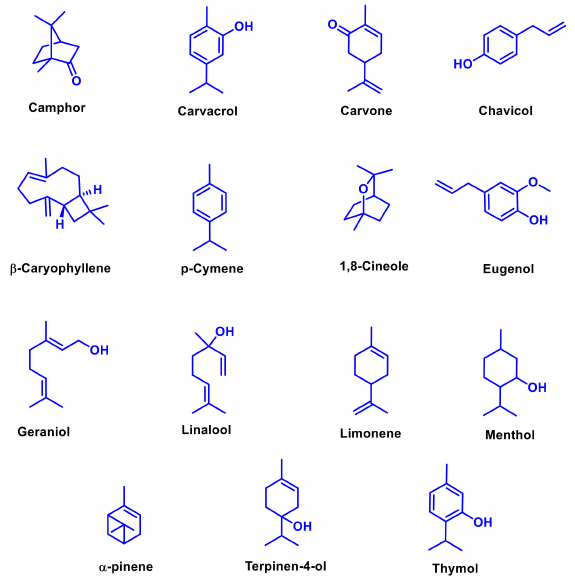
Figure 2. Major and biologically important bioactive constituents present in essential